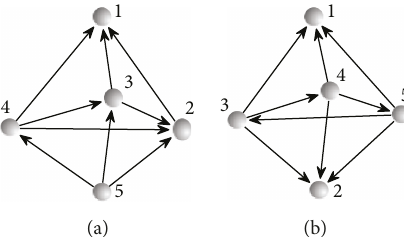
Figure 1: Examples of graph in a 3D space: (a) an acyclic minimally structural persistent graph; (b) minimally persistent but not structurally persistent